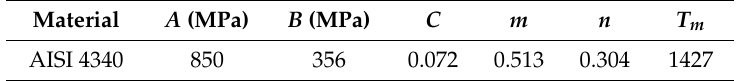
. ε 0 = 1; T r = 25 ◦ C) [40].